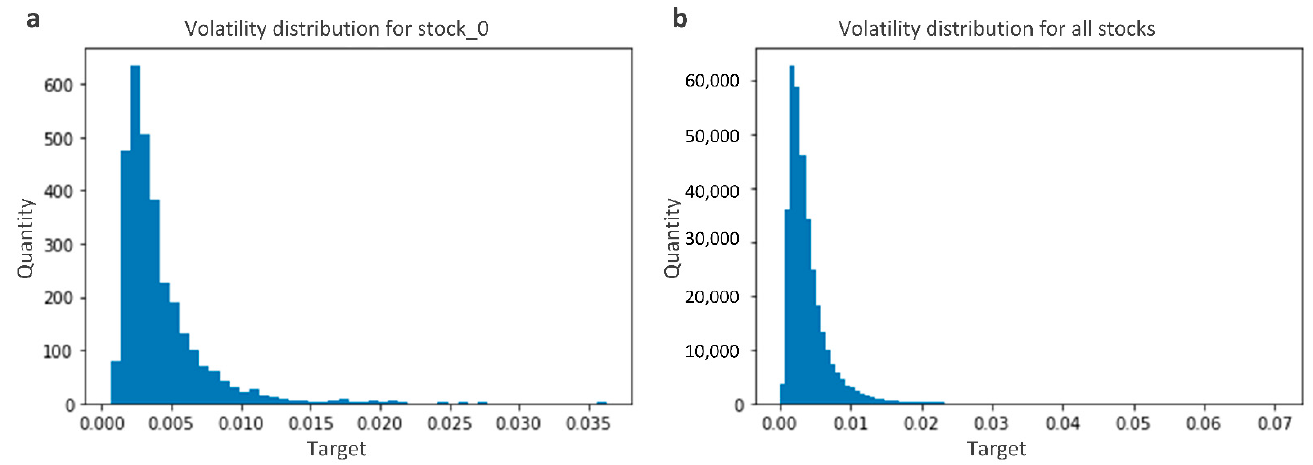
Figure 15. Volatility distribution (( a , b ) denote the data distribution of single stocks and all stocks.).